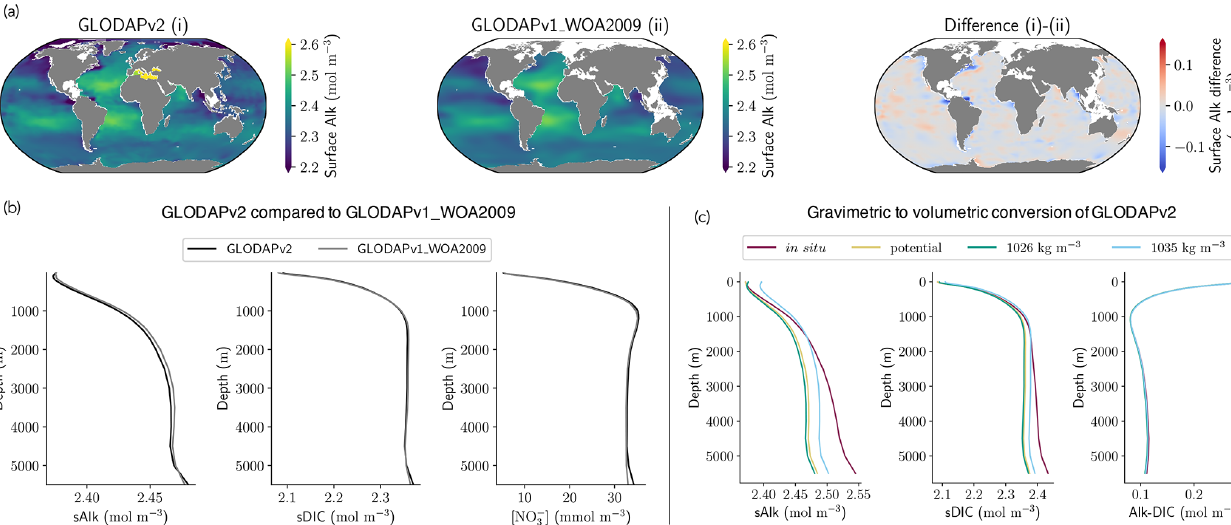
Figure 11. Influence of the observational data product and the Alk and DIC conversion strategy. (a) Maps of surface-ocean Alk for (i) GLO- DAPv2, (ii) GLODAPv1_WOA2009, and their difference (i)–(ii). (b) GLODAPv2 and GLODAPv1_WOA2009 vertical profiles of sAlk, sDIC, and nitrate concentration for the open ocean. (c) Vertical profiles of sAlk, sDIC, and Alk–DIC for the open ocean, with gravimetric GLODAPv2 data converted into volumetric units using either in situ density, potential density, or a constant density of 1026kgm − 3 or 1035kgm − 3